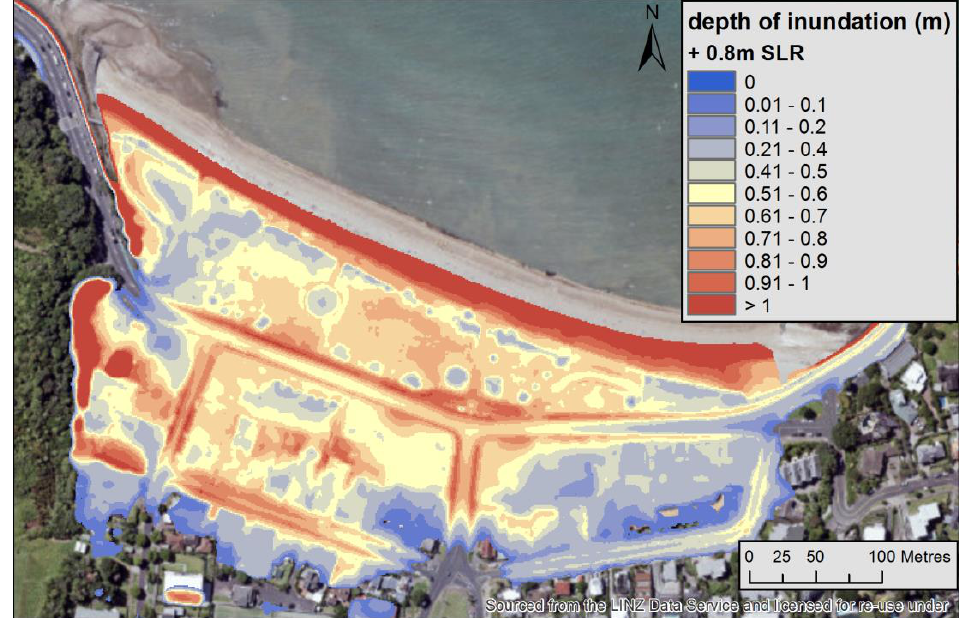
Figure 6. Depth of flooding at Mission Bay, Auckland, for a 1% AEP storm-tide at present-day MSL + 0.8 m SLR. Flooding was modelled using a static GIS technique. All areas below the modelled sea level are shown as inundated, regardless of connection to the sea—some inland areas may not become inundated as shown if such interconnections exist.